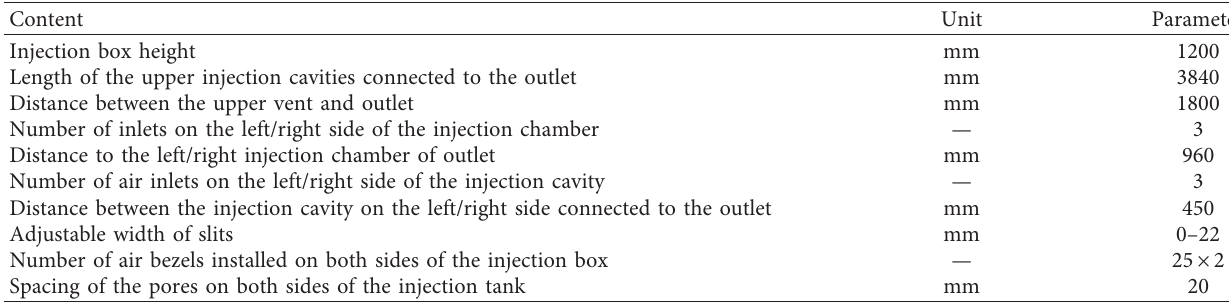
Figure 6: Appearance structure of upper injection box: (a) schematic diagram of the upper injection box; (b) left view of the upper injection box. Table 1: Main parameters of the